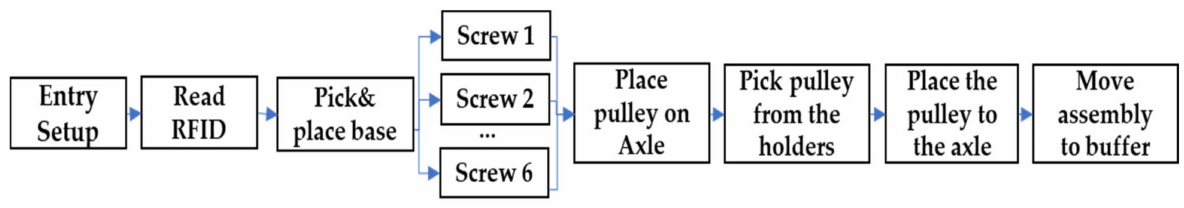
Figure 6. Assembly steps for experimental scenario